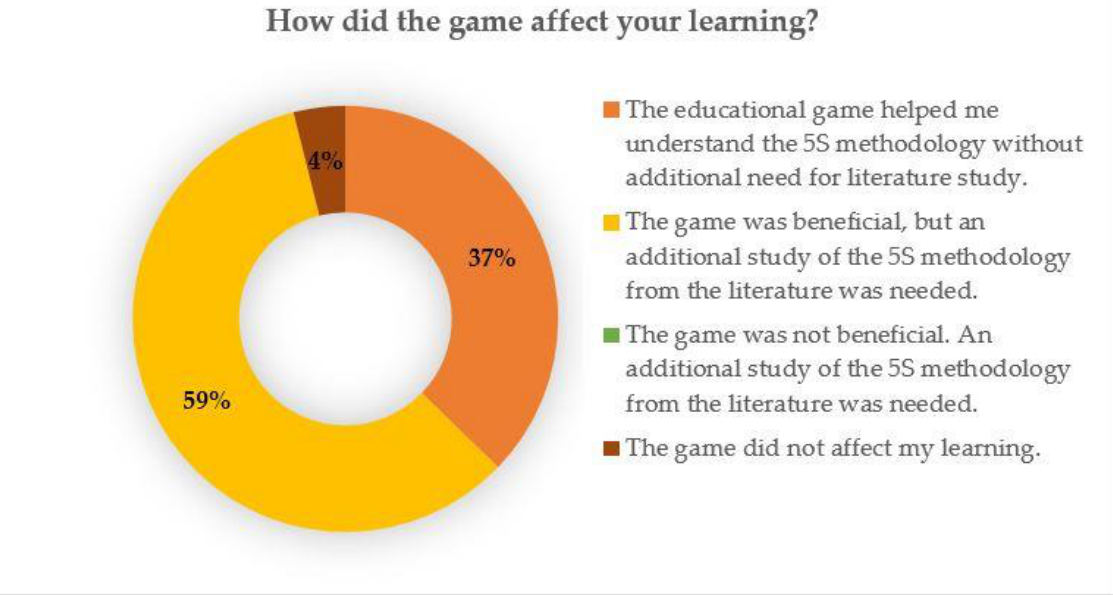
Figure 14. Subjective evaluation of the educational game impact on students’ learning.